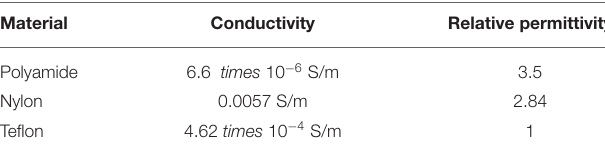
TABLE 1 | Dielectric properties of the materials considered to model the helmet and the cable.